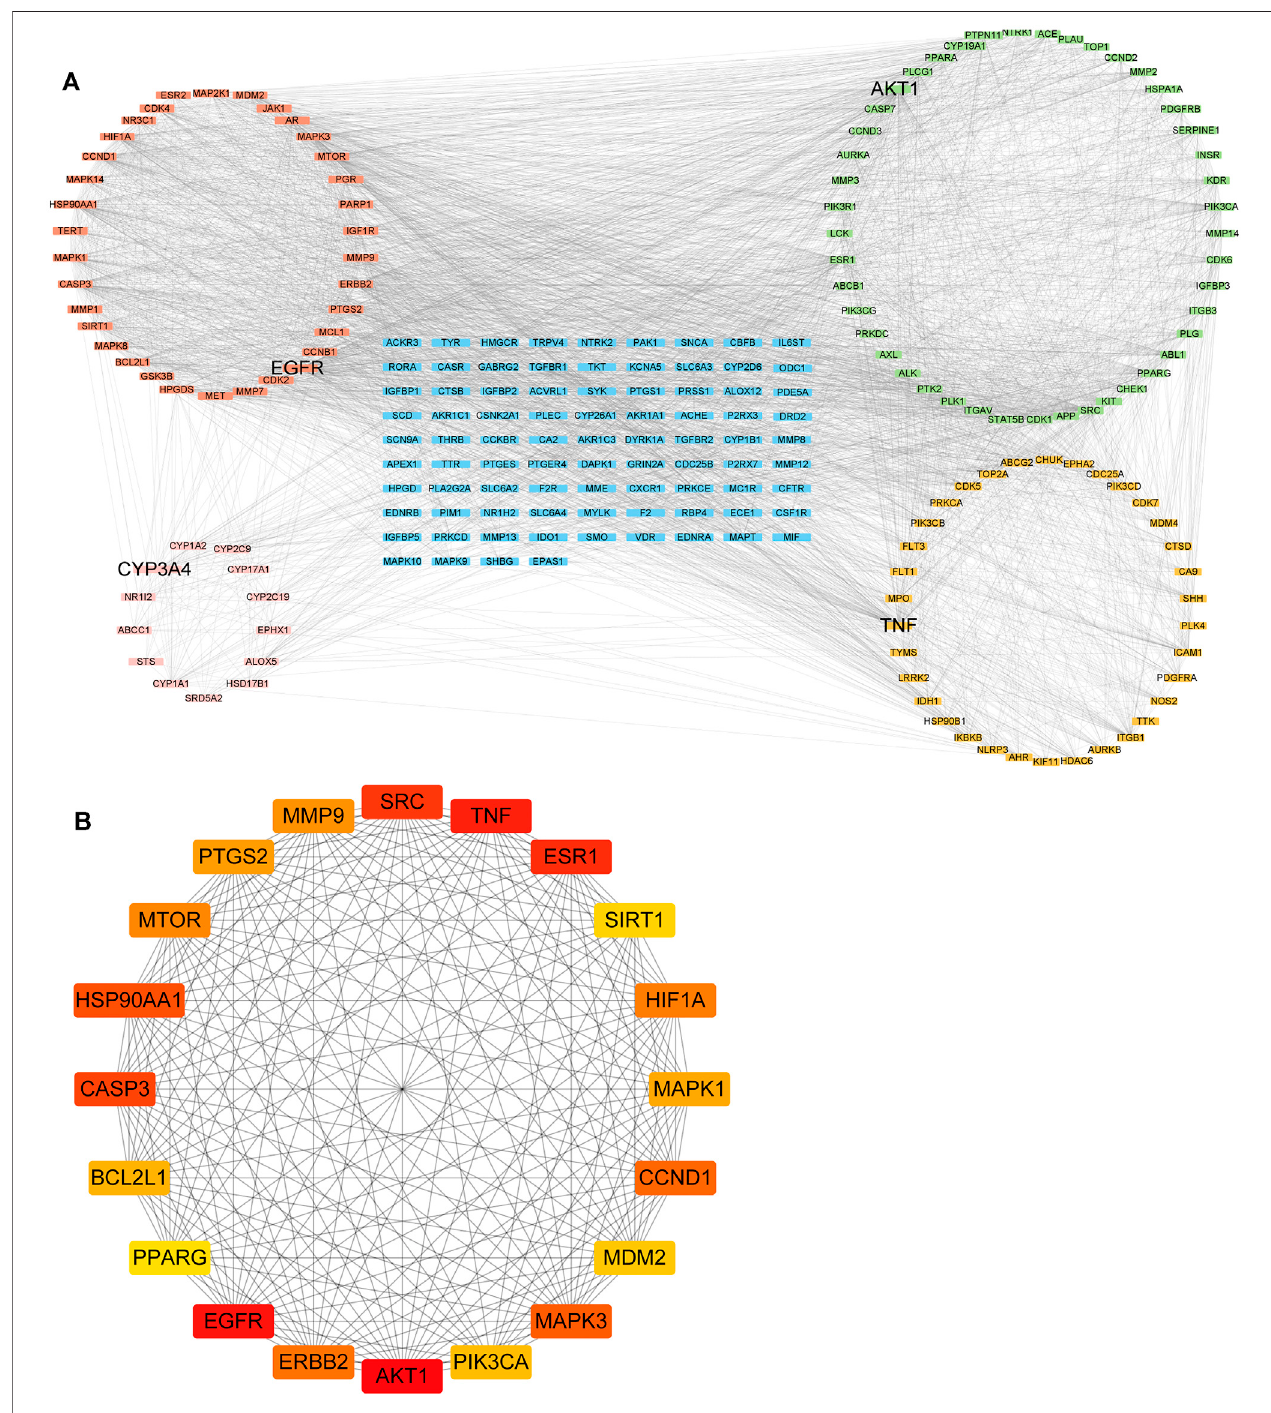
FIGURE 3 | The protein – protein network of 212 intersecting targets. (A) Four modules (EGFR, AKT1, TNF, and CYP3A4) were identi fi ed from the whole PPI network. (B) The top 20 Core targets are determined by the degree. Color represented the target degree.